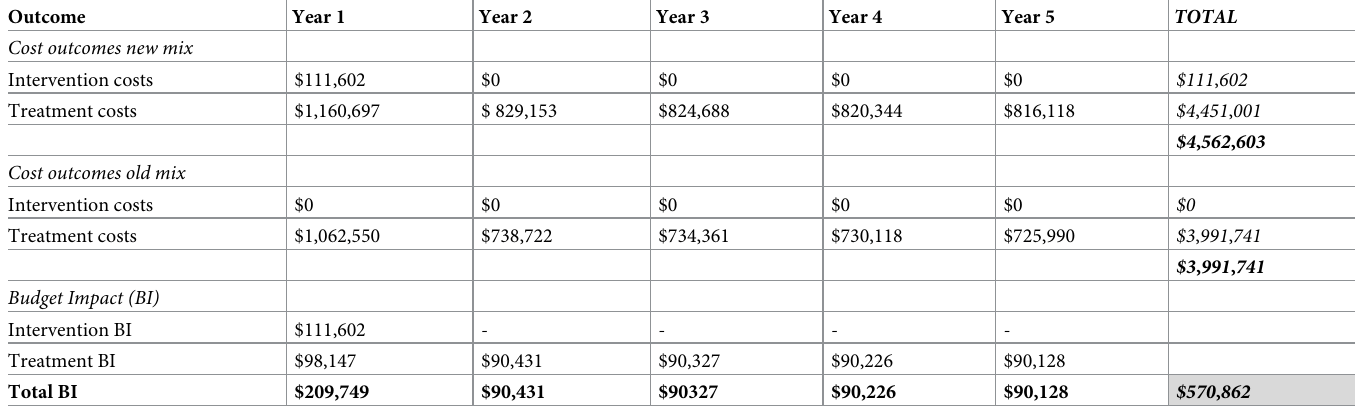
Table 5. Budget impact of new treatment mix over five